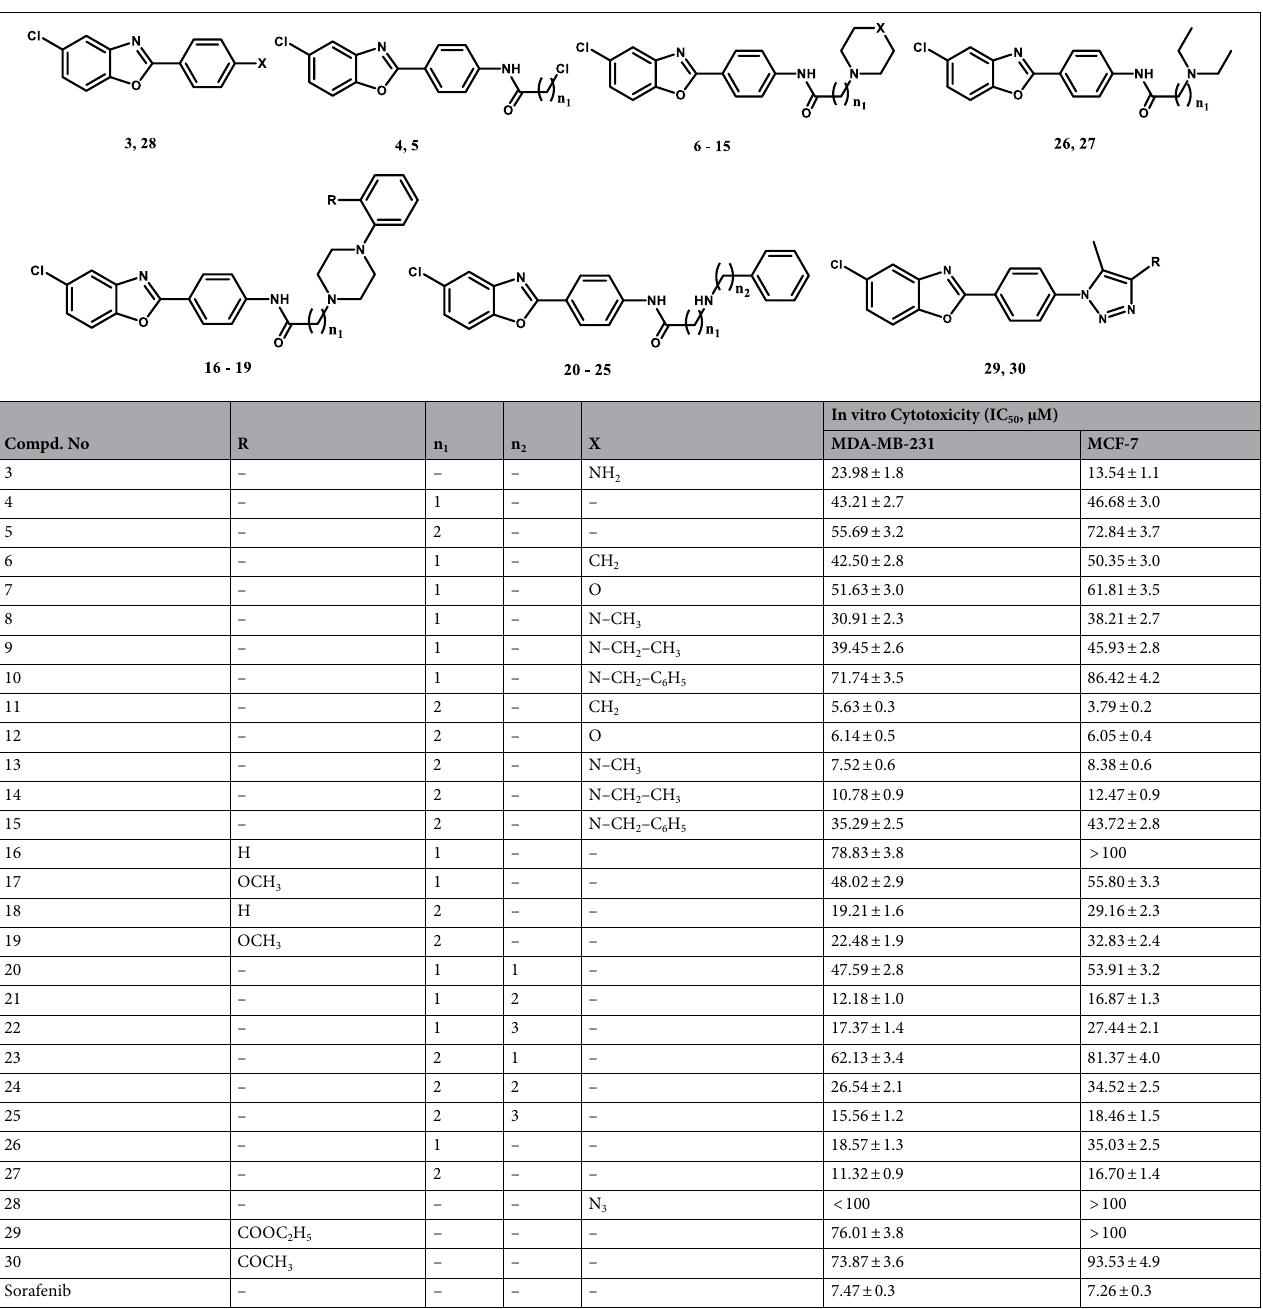
investigate their possible mechanism of cytotoxicity. Results were expressed as IC 50 values (Table 2). Olaparib